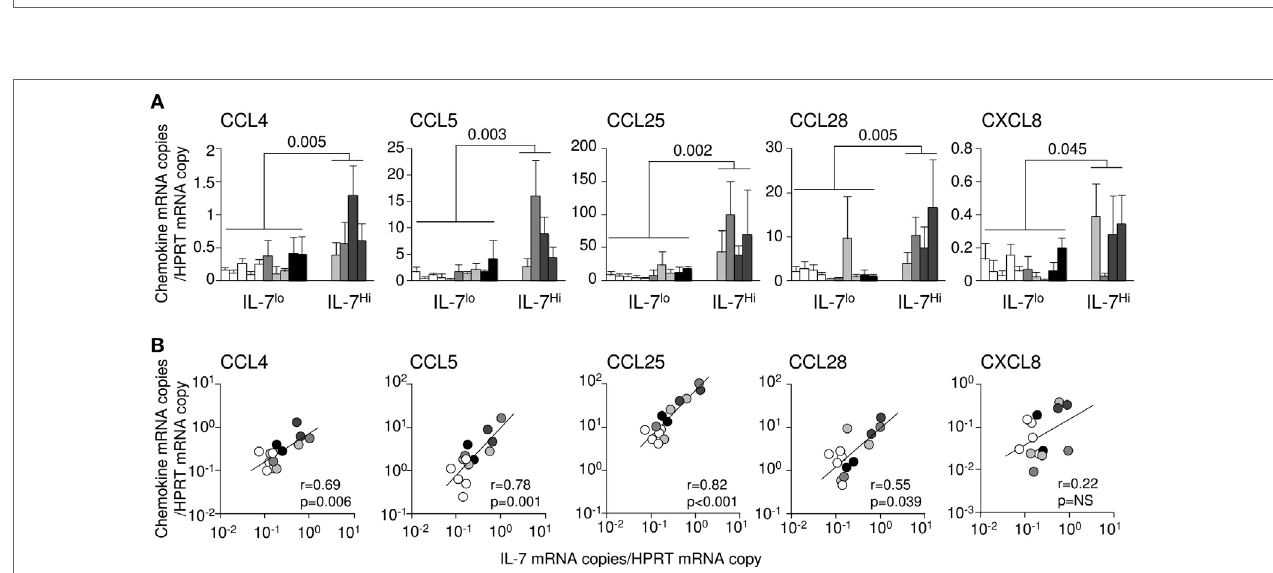
FigUre 2 | assessment of the chemokine expression network in the ileal mucosa of simian immunodeficiency virus-infected macaques . Thirteen chemokines were quantified by RT-qPCR in ileal tissues sampled at day 0 (D0; macaques #1 open squares, #2 close diamonds, #3 close circles, #4 gray triangles, and #5 open circles), day 3 (D3; #6 open squares, #7 close circles, and #8 close diamonds), day 7 (D7; #9 close circles and #10 open squares), day 10 (D10; #11 close circles and #12 open squares), or day 14 (D14; #13 close circles and #14 open squares) pi (chemokine mRNA copies/HPRT mRNA copy). The bold gray line on days 3, 7, 10, and 14 graphs represents the median of chemokine concentrations of the five healthy macaques (D0). For each macaque, each dot represents the median of three to five independent samples, quantified in triplicate. Statistical analysis was performed individually for each infected macaque, compared to each healthy control. A given chemokine was considered as overexpressed in one infected macaque if significantly different from all healthy controls, tested independently (* p < 0.05 for macaque #9, #11, or #13, as compared to each uninfected monkeys; # p < 0.05 for macaque #10, #12, or #14, as compared to each uninfected monkeys; Mann–Whitney two-tailed U test).